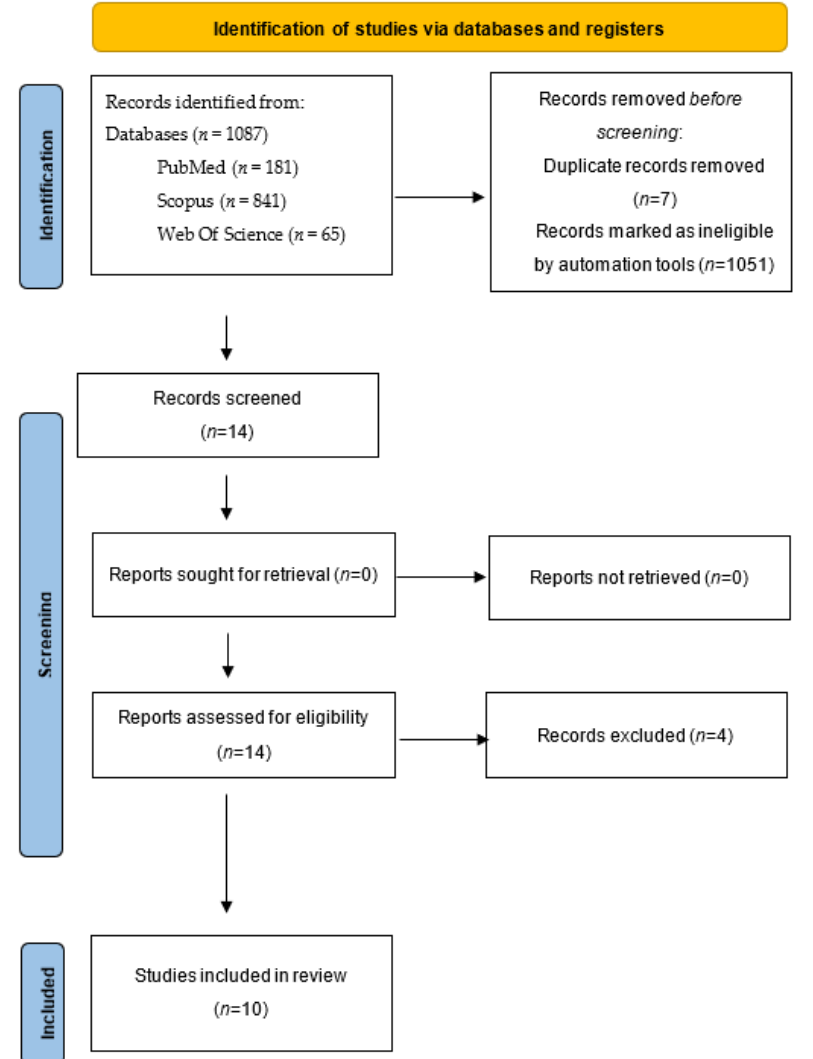
Figure 1. PRISMA flow diagram of the systematic literature search.